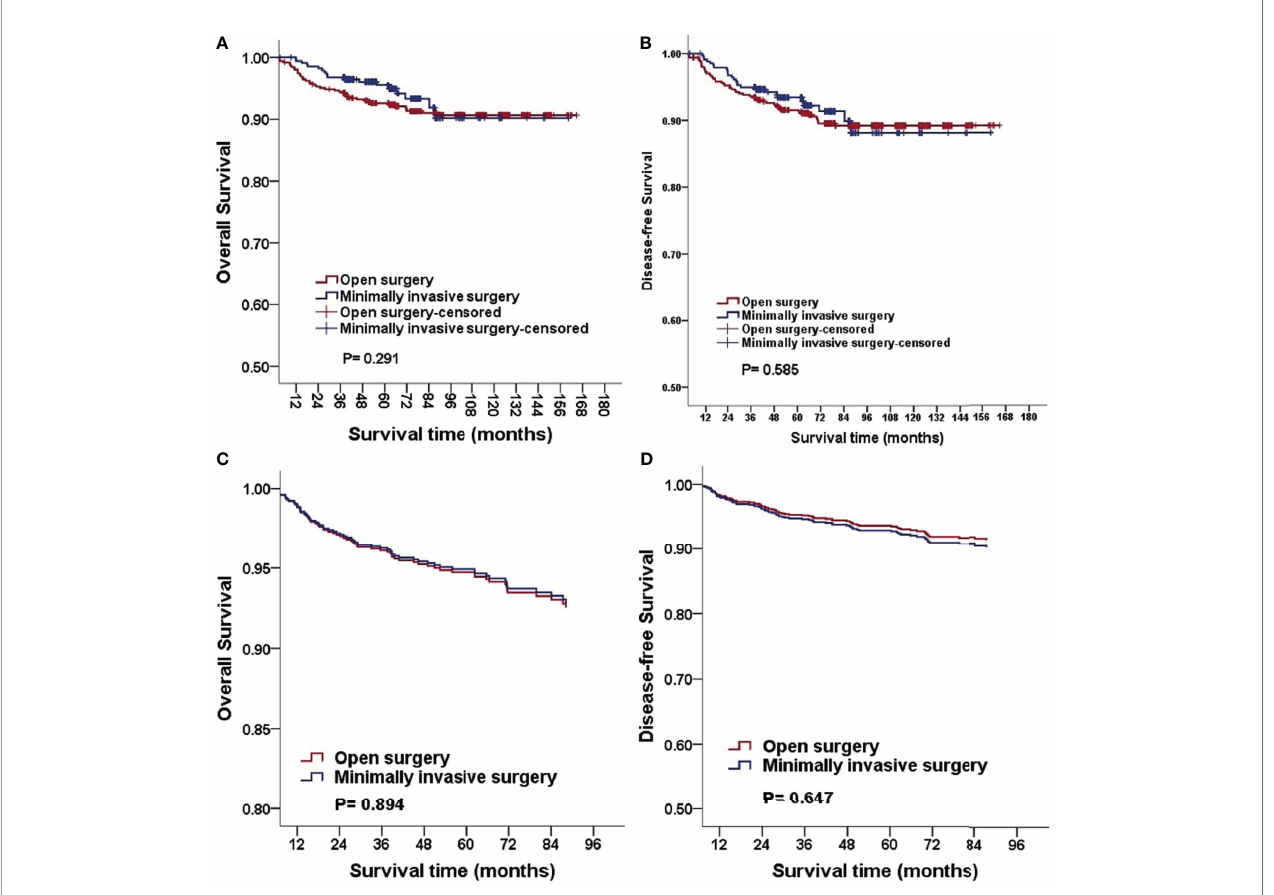
FIGURE 1 | Kaplan-Meier analysis of the OS and DFS for patients strati fi ed by surgical approach (A, B) . The OS and DFS adjusted for clinicopathological factors for patients strati fi ed by surgical approach (C, D) . MIS, minimally invasive